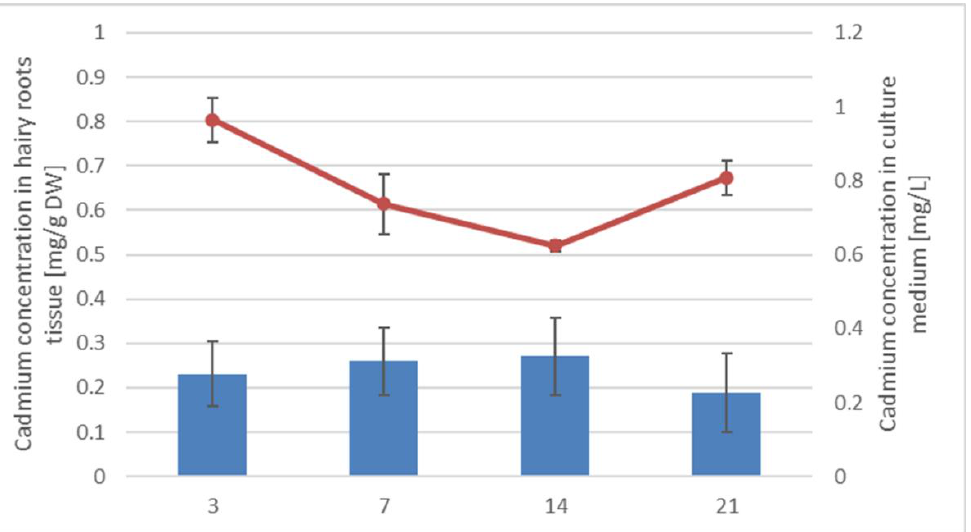
Figure 3. Cadmium concentrations in hairy roots tissue (blue bars) and culture medium (red curve). Values represent mean ± SD.